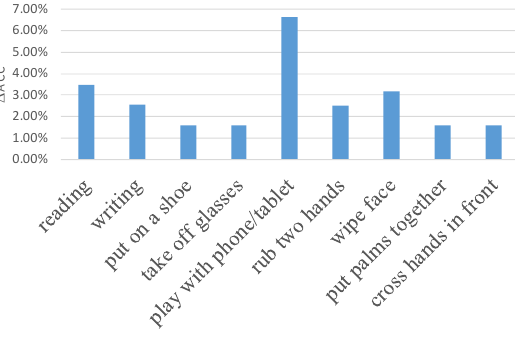
Figure 7. The accuracy promotion for several actions with ASGCM. ∆ Acc denotes the promotion of